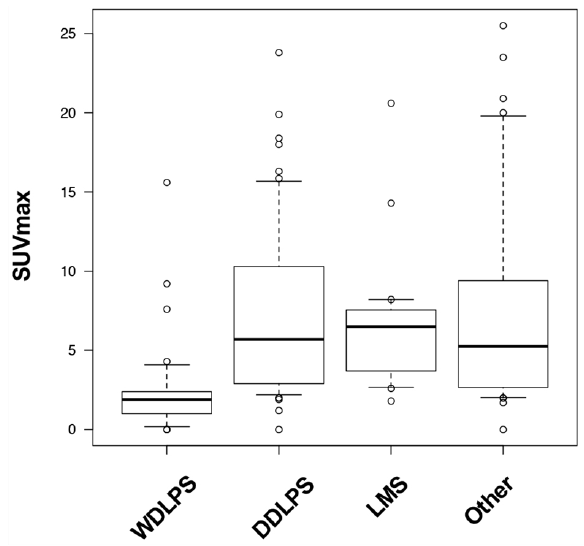
Figure 3. Distribution of SUVmax by histologic subtype.